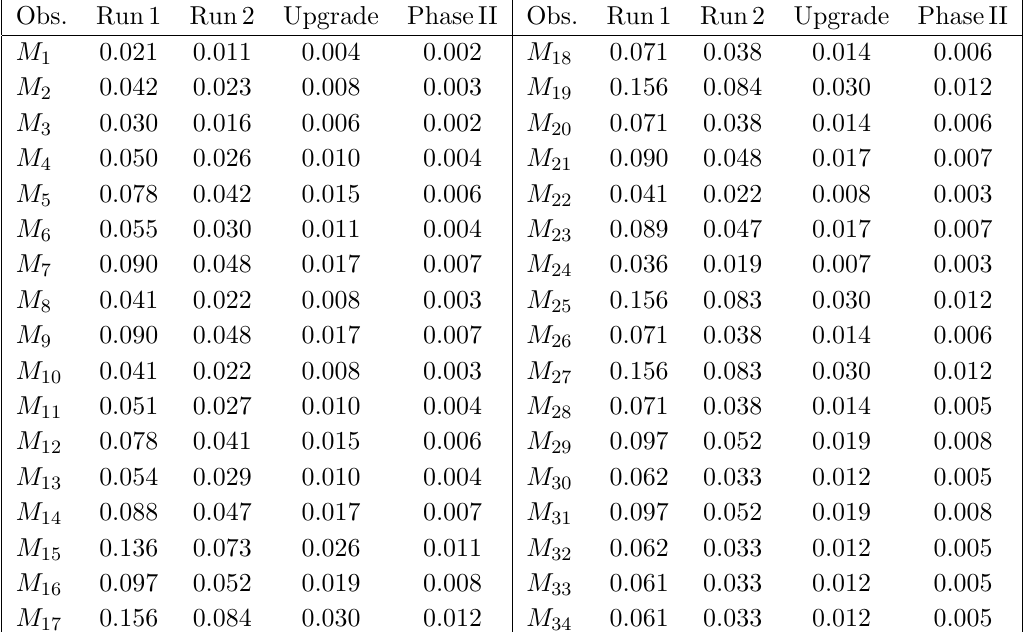
+ (cid:22) (cid:0) decay at b ! (cid:3) (cid:22) (cid:3) (cid:22) + (cid:22) (cid:0) ! 1000 (cid:24) 8 000 candidates in 50 fb (cid:0) 1 (cid:24) 50 000 (cid:24)